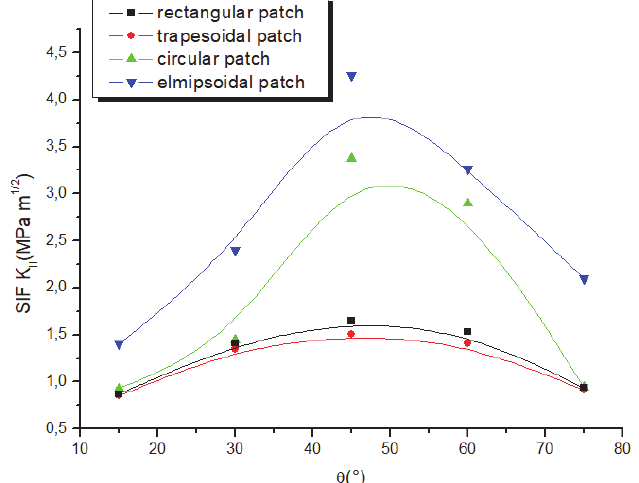
Figure 14: Variation of the (SIF) in mode II of the inclined crack for the different shape of patch (a =